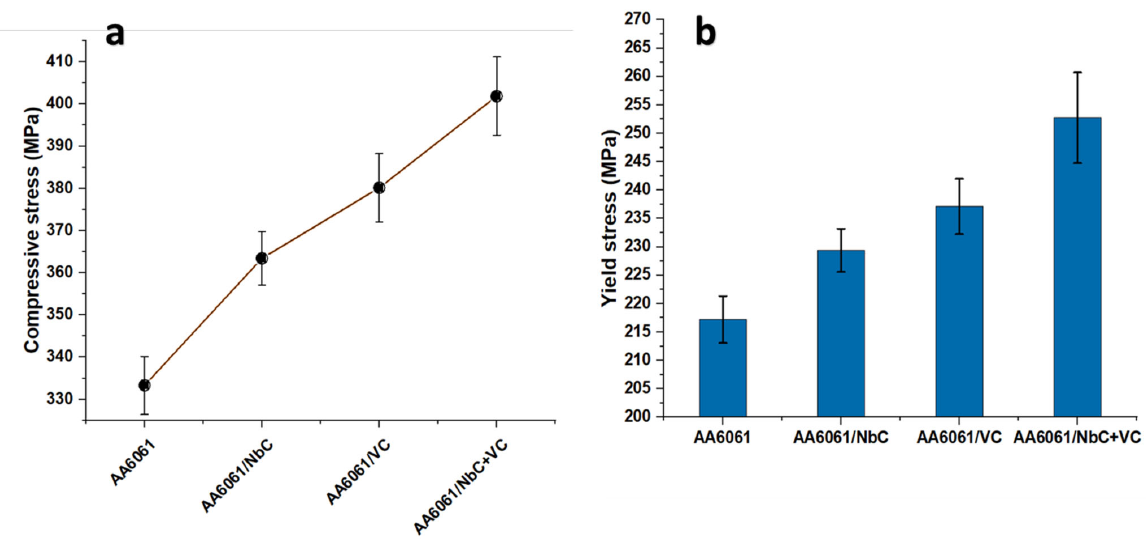
Figure 9. Mechanical properties obtained from compressive test ( a ) ultimate compressive stress, ( b ) yield stress. ( b ) yield